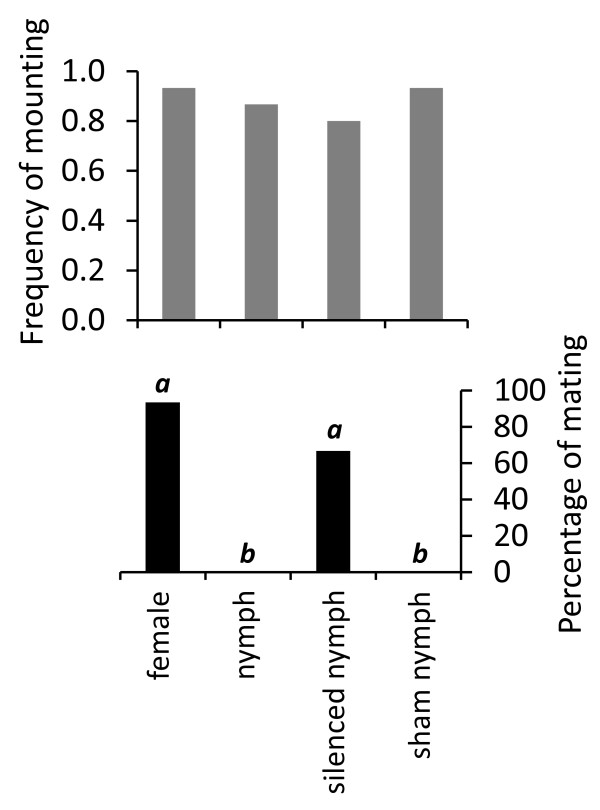
Mating repulsion of male Cimex lectularius is regulated by the nymph-emitted alarm pheromone. (a) Frequency of male mounting on females and nymphs (n = 15 for each treatment) is the same (Kruskal-Wallis test: χ2 = 1.749, P = 0.626). (b) The percentage of mating with females (n = 14), nymphs (n = 12), silenced nymphs (with covered dorsal abdominal glands (n = 13) and sham-treated nymphs (n = 14), on the other hand, differs. Different letters represent significant differences in percentage of mating among the different associations.